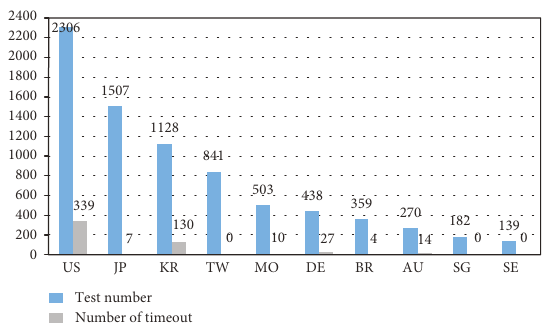
Figure 18: Comparison of the test number and timeout among di ff erent regions in the blanket